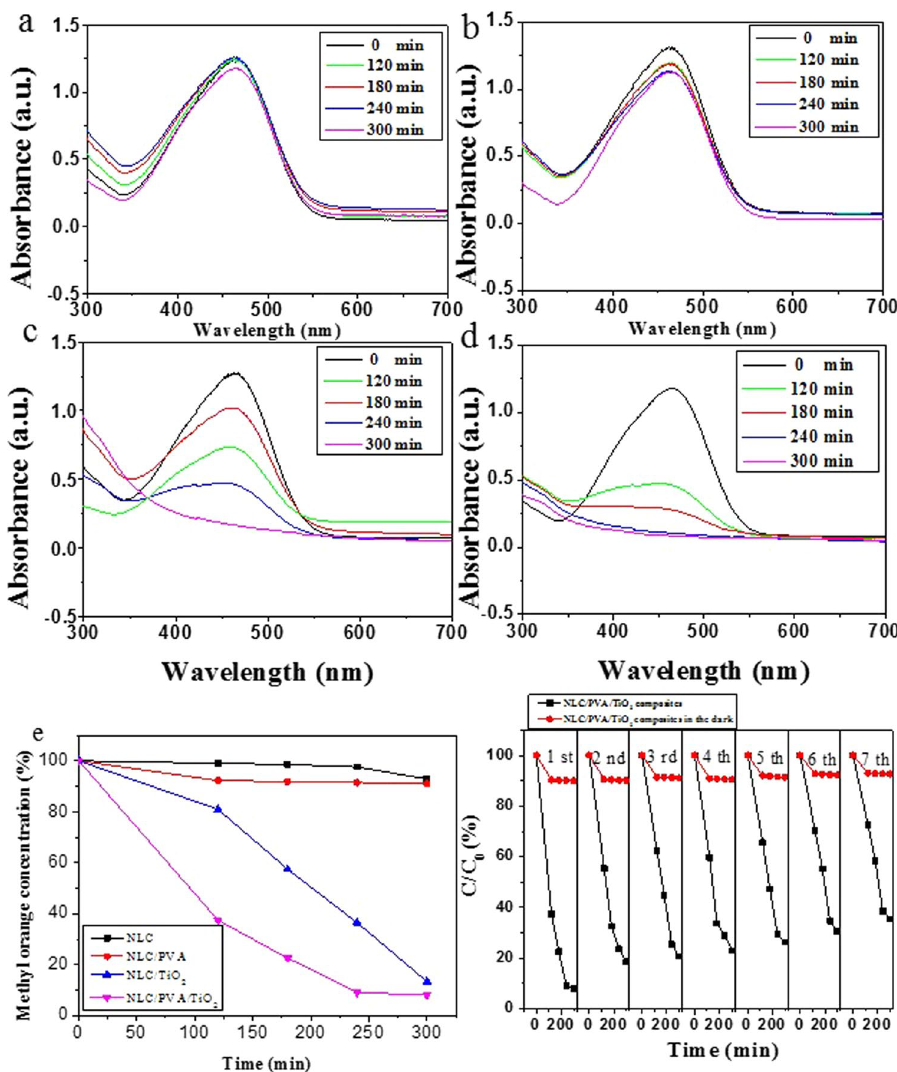
2 as photocatalyst under UV irradiation for 300